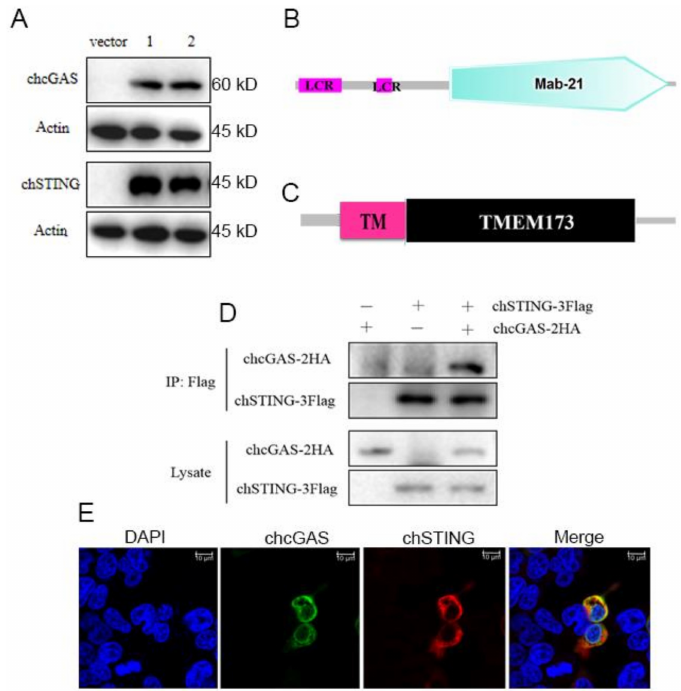
Figure 1. The structures, expressions, and interaction of chcGAS and chSTING. ( A ) The pcDNA-chcGAS-3FLAG (clones 1 and 2) and pcDNA-chSTING-3FLAG (clones 1 and 2) plus pcDNA3.1 (vector) were transfected into 293T cells in 24-well plate (3 × 10 5 cells / well) for 48 h. The cells samples were detected by Western-blotting with anti-FLAG mAb. ( B,C ) The predicted chcGAS and chSTING protein structure and domains predicted by SMART software. LCR: low complexity region, TM: transmembrane region (28aa–50aa). ( D ) chcGAS-HA and chSTING-FLAG were co-transfected into 293T cells in 6-well plate (7 × 10 5 cells / well), and the cell lystes were immunoprecipitated with anti-FLAG mAb and subjected to Western-blotting using the indicated antibodies. ( E ) chcGAS-HA and chSTING-FLAG were co-transfected into 293T cells in 24-well plate, and the cells were examined for co-localization by con-focal fluorescence